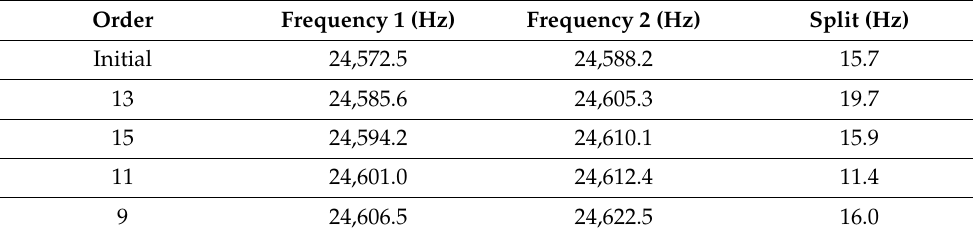
Table 4. Modal frequencies and frequency splits recorded during the tuning process.